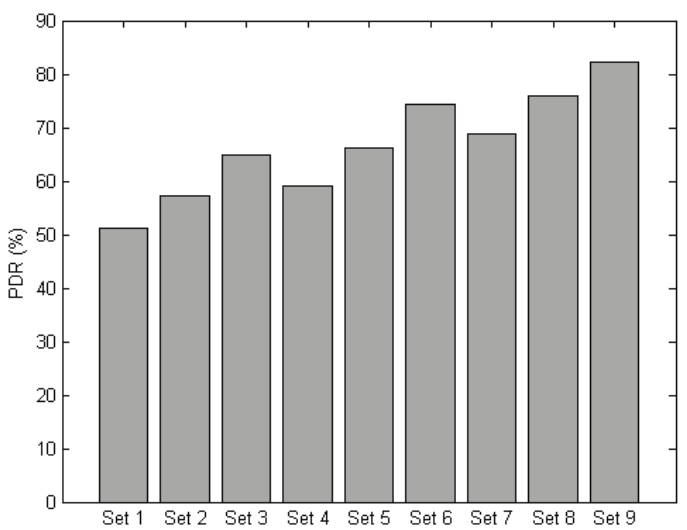
Figure 15. PDR of the protocol sets.